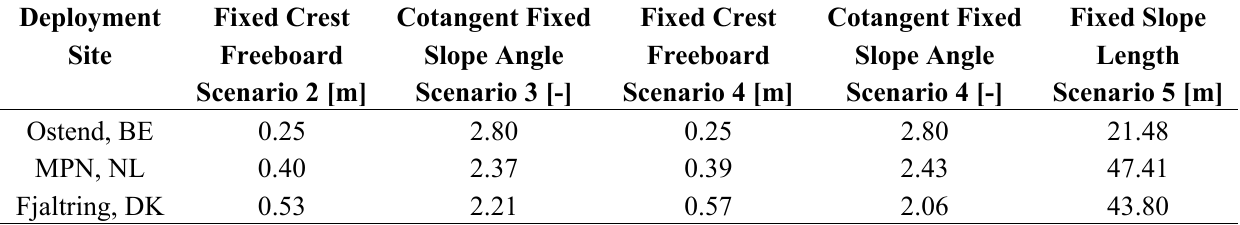
Table 7. Fixed geometrical parameters for scenarios 2 to 5 at the three possible deployment sites.